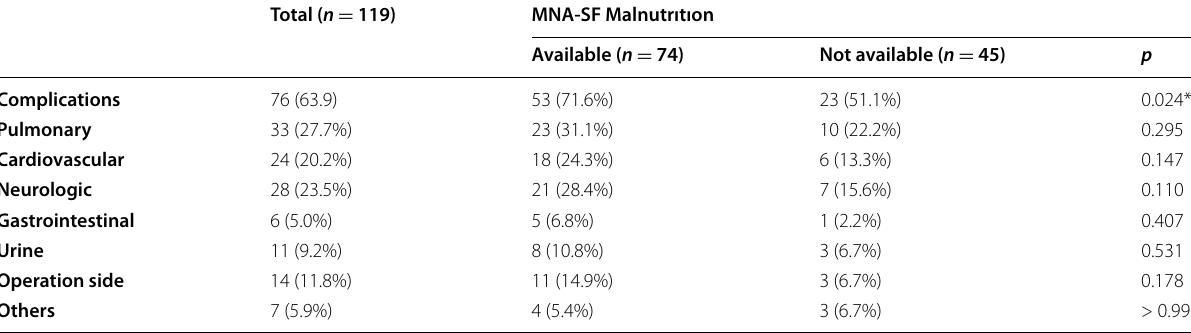
Table 4 Relationship between malnutrition and complication according to MNA-SF test